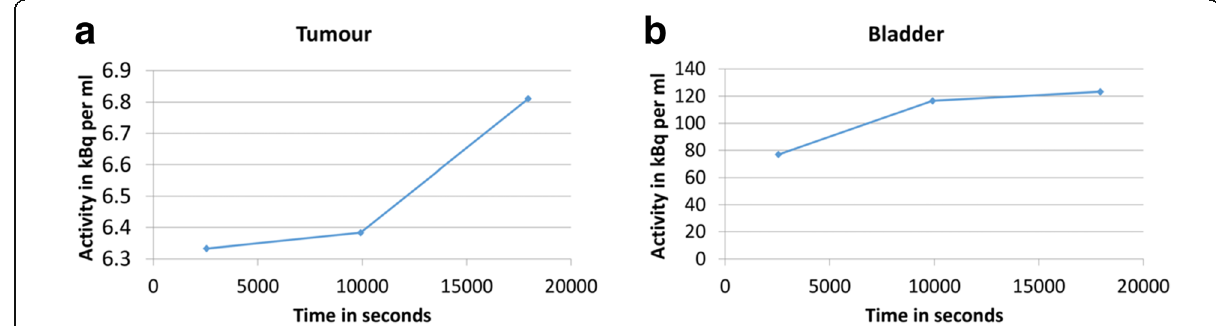
Fig. 7 Examples from enema group showing TAC at 45 min, 2 h and 4 h PET from tumour ( a ) and bladder ( b ). The TAC in a and b correspond to patient in Fig. 6. The TACs show the effect of bladder activity on the apparent tumour activity after removal of the non-tumour activity in the rectum before the 4 h time point. The changes in tumour activity were much smaller compared to those seen in bladder as apparent from the y-axis. Since the patient emptied their bladder between 2 and 4 h, the bladder activity showed an increase of only 6% and correspondingly an increase of 6.25% in tumour activity was observed. However, it is still unclear if this increase in tumour activity is due to the spill-out from bladder or accumulation of tracer in hypoxic cells, or both. Alternatively, it is possible that the [ 18 F]FMISO in hypoxic cells reached an equilibrium state by 4 h post injection, and the increase in tumour activity could be purely an effect of increased bladder activity. TAC = time-activity curve; min = minute; h = hour; PET = positron emission tomography; % = percentage; [ 18 F]FMISO = [ 18 F]fluoromisonidazole; kBq = kilo Becquerel; ml = millilitre; 1 millilitre = 1 cm 3